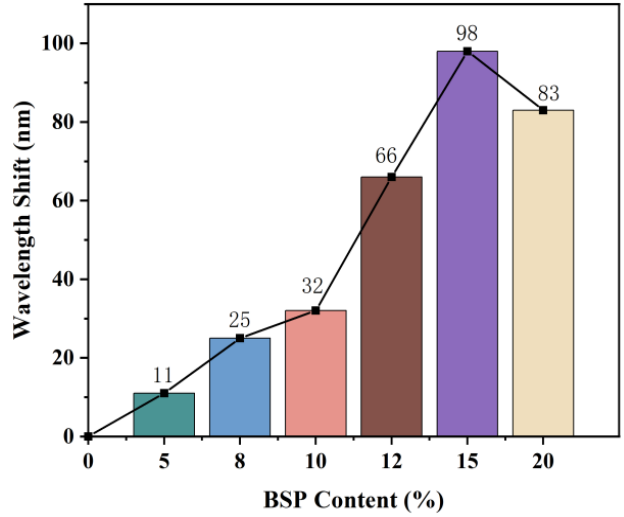
Figure 5. The maximum redshift of photonic crystal hydrogel with different BSP contents in 30% H 2 O 2 solution.